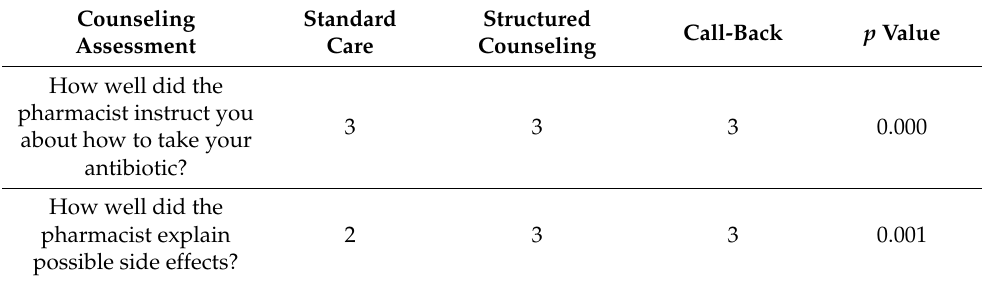
Table 3. Patient Feedback on Counseling Received by Pharmacists within Study